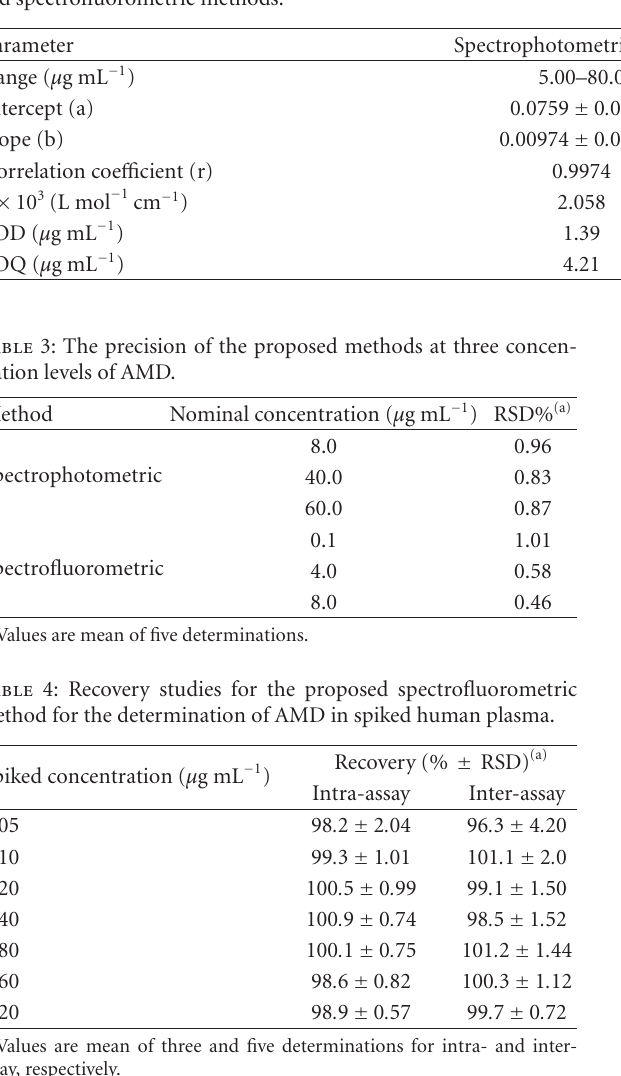
Table 2: Quantitative parameters and statistical data for determination of amantadine hydrochloride by the proposed spectrophotometric and spectrofluorometric methods.